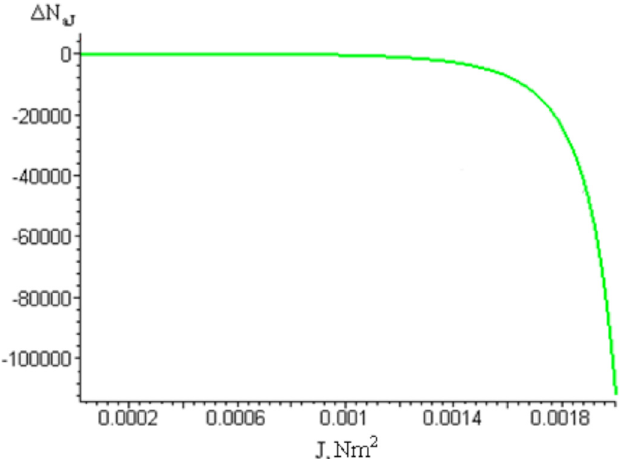
Fig. 8. The boundary of the change in the absolute additive error of the torque MM under the conditions of the deviation of the impact value on D